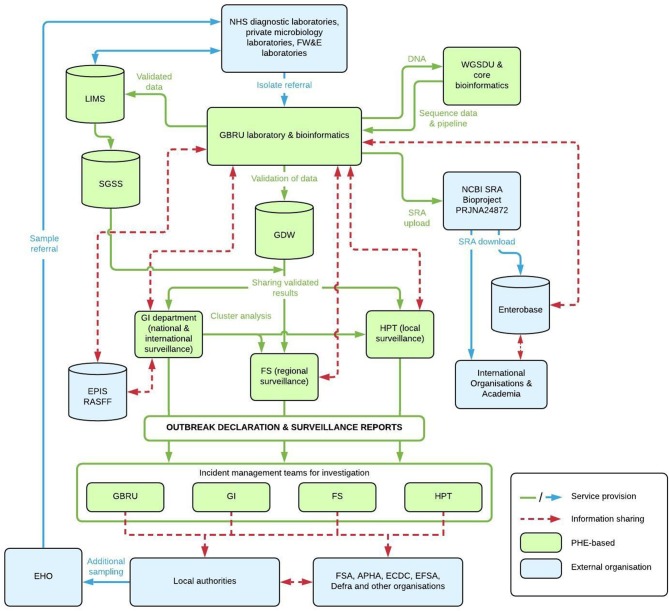
Flow Chart of Service Provision and information workflows between PHE and external organizations for Salmonella reference microbiology and surveillance. NHS, National Health Service; FW&E, Food, Water and Environmental; PHE, Public Health England; GBRU, Gastrointestinal Bacteria Reference Unit; WGSDU, Whole Genome Sequencing Delivery Unit; LIMS, Laboratory Information Management System; GDW, Gastro Data Warehouse; SGSS, Second Generation Surveillance System; NCBI, National Center for Biotechnology Information; SRA, Short Read Archive; GI, Gastrointestinal; FS, Field Services; HPT, Health Protection Team; EPIS, Epidemic Intelligence Information System; RASFF, Rapid Alert System for Food and Feed; EHO, Environmental Health Officers; FSA, Food Standards Agency; APHA, Animal and Plant Health Agency; ECDC, European Center for Disease Prevention and Control; EFSA, European Food Safety Authority; DEFRA, Department for Environment, Food and Rural Affairs. Databases/Platforms include GDW, LIMS, EPIS, RASFF, and Enterobase.